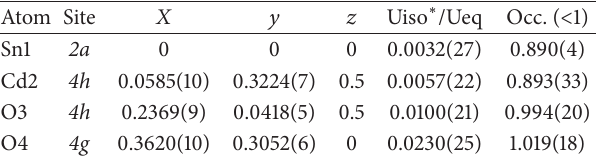
Table 2: Fractional atomic coordinates and isotropic